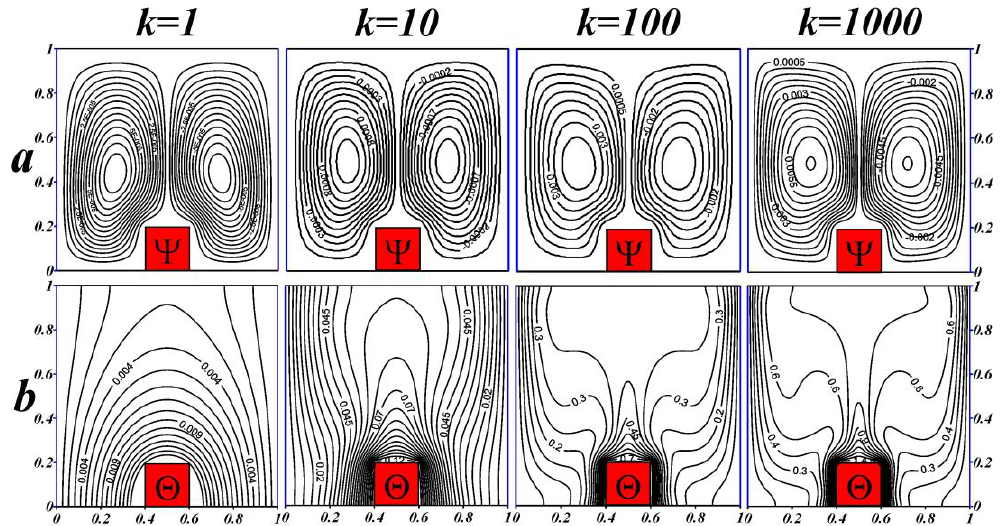
Figure 9. Streamlines Ψ ( a ) and isotherms Θ ( b ) at n = 0.8, Pr = 10 2 , Ra = 10 5 and different k.